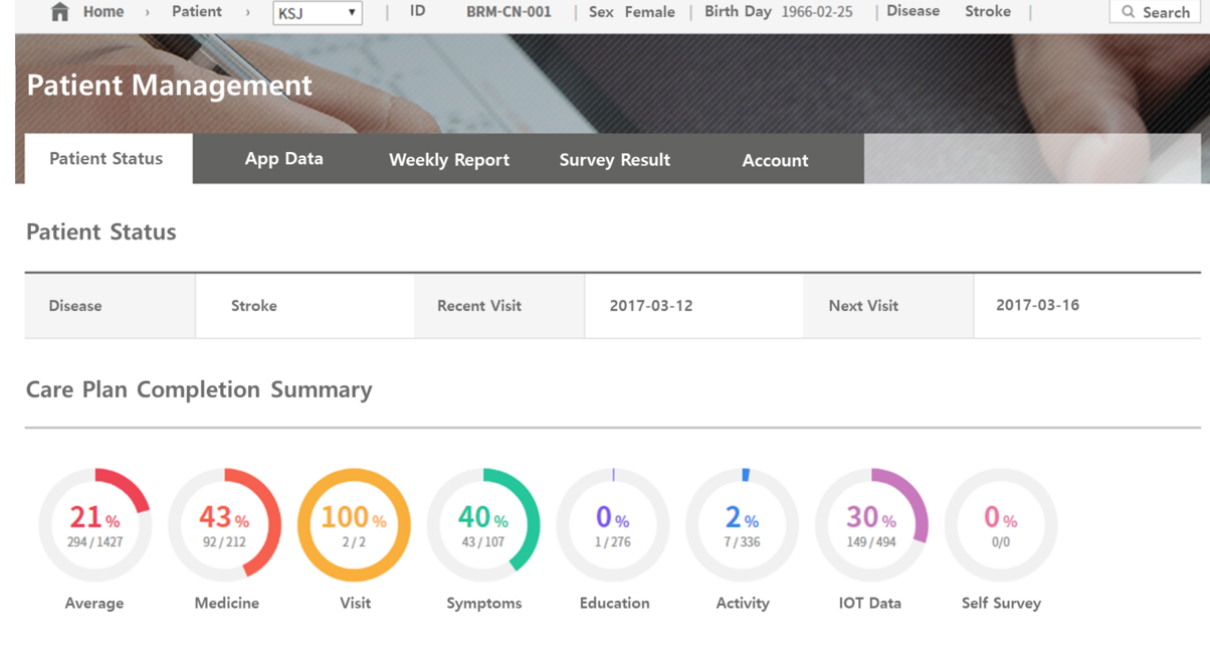
Figure 3. Summary of care plan completion on the patient management